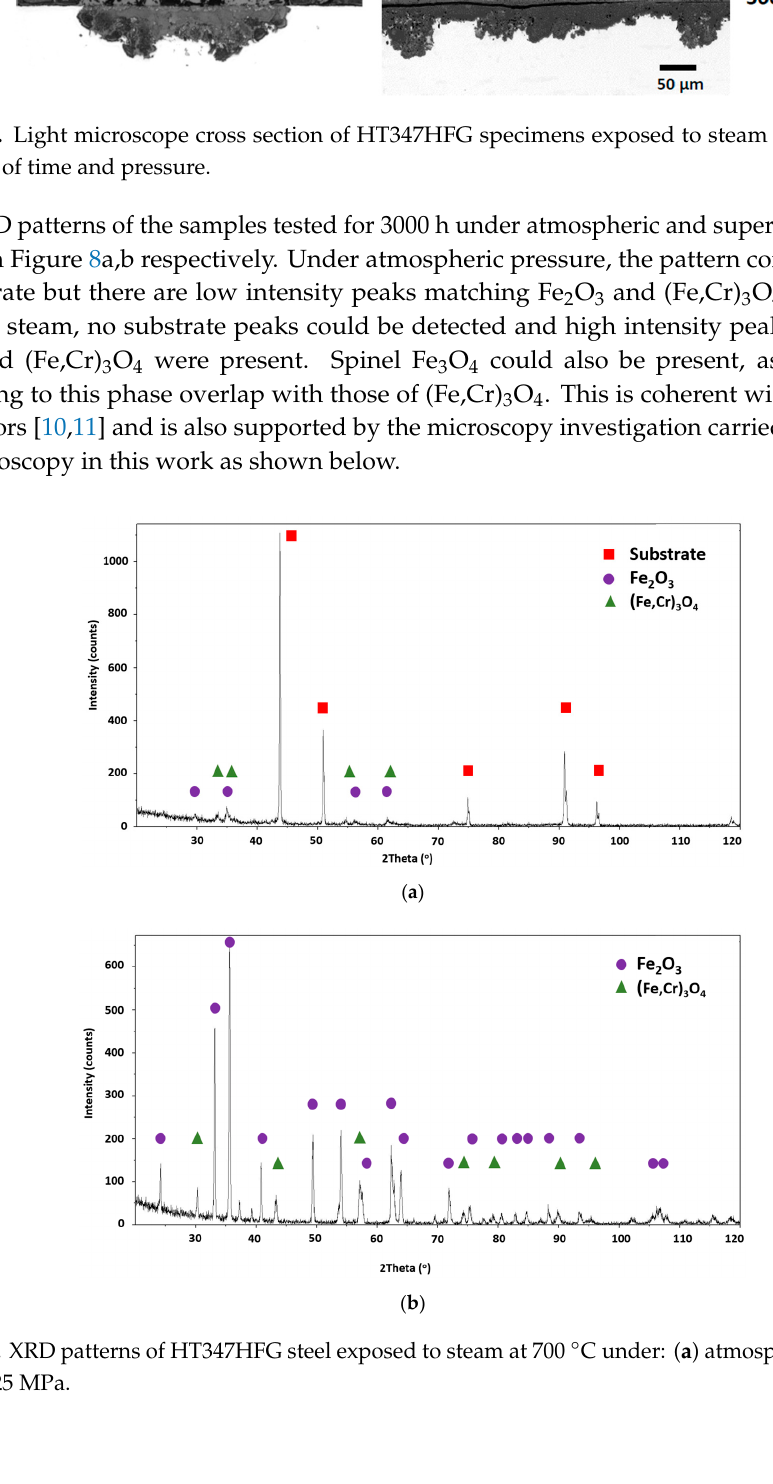
Figure 8. XRD patterns of HT347HFG steel exposed to steam at 700 °C under: ( a ) atmospheric pressure and ( b ) 25 MPa.